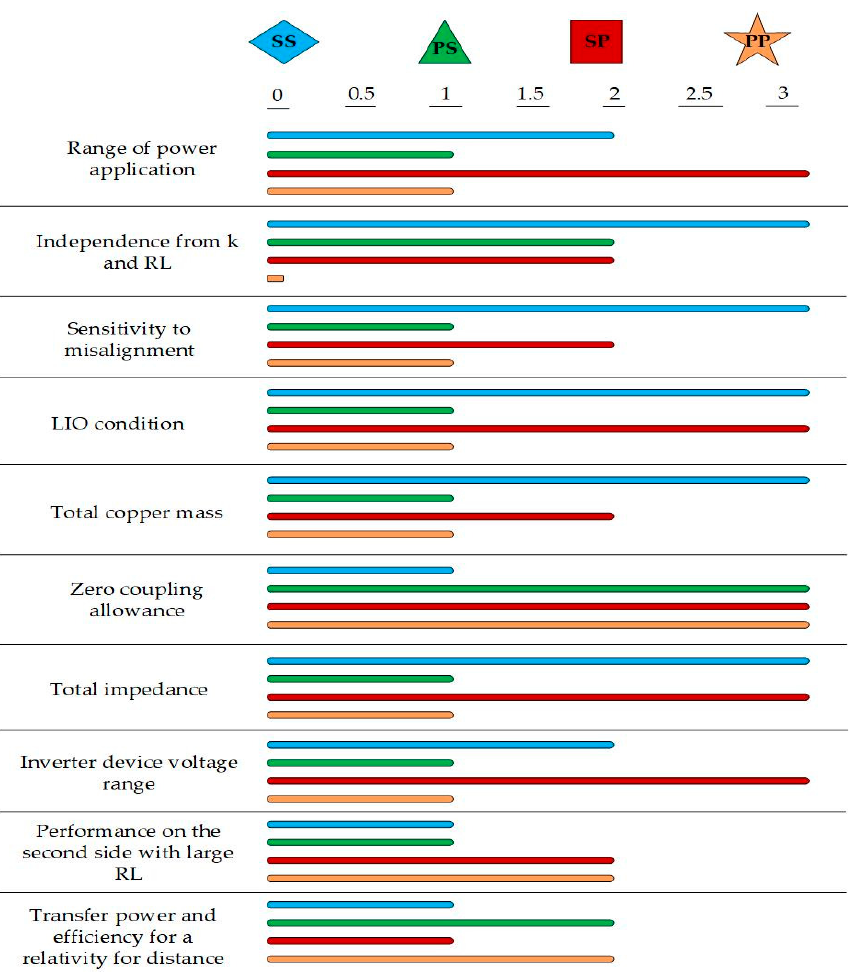
Figure 16. Comparison diagram of the initial topology of compensators.